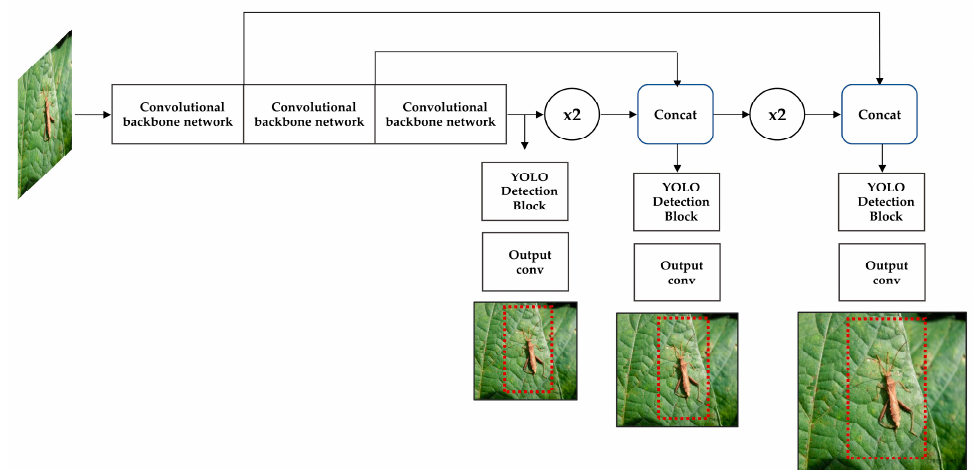
Figure 3. YOLOv3 architecture. The architecture of the YOLOv3 model using DarkNet53-based convolutional backbone network. The convolutions, skip connections, and 3 prediction heads enable YOLOv3 to process images at a different spatial compression.